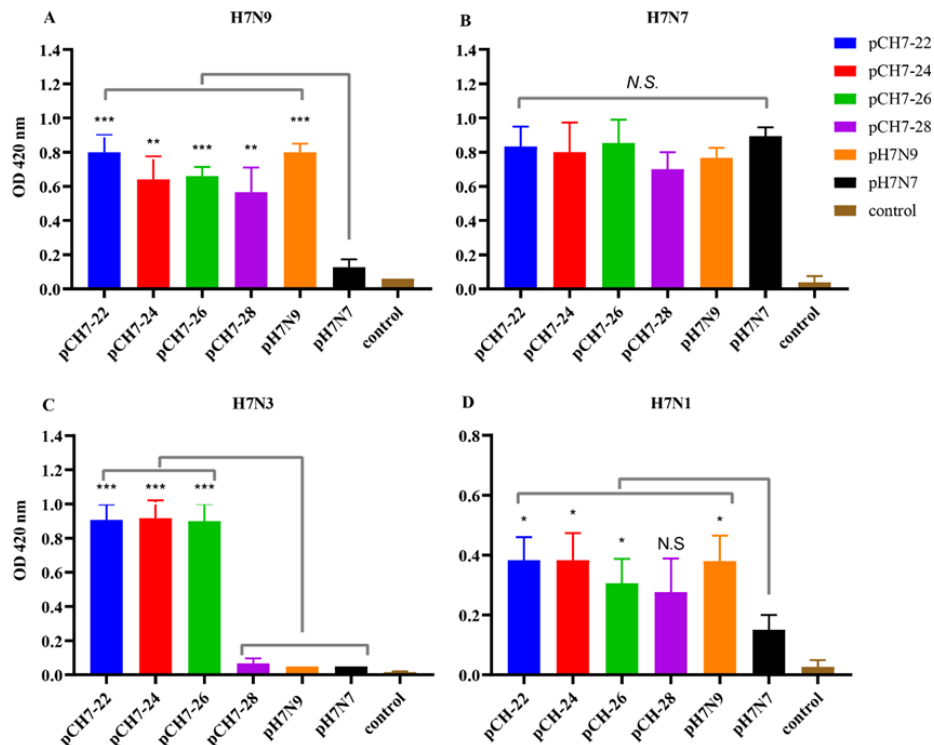
Figure 4. DNA vaccines encoding consensus H7 proteins elicit broadly reactive antibody responses in mice. Six to 8-week-old female BALB/c mice (10 mice per group) were immunized twice with a 3-week interval. Each vaccination consisted of 30 μg pCH7-22, pCH7-24, pCH7-26, pCH7-28, pH7N9, and pH7N7 dissolved in 30 µ L Tris-EDTA bu ff er. Two weeks after the second immunization, sera